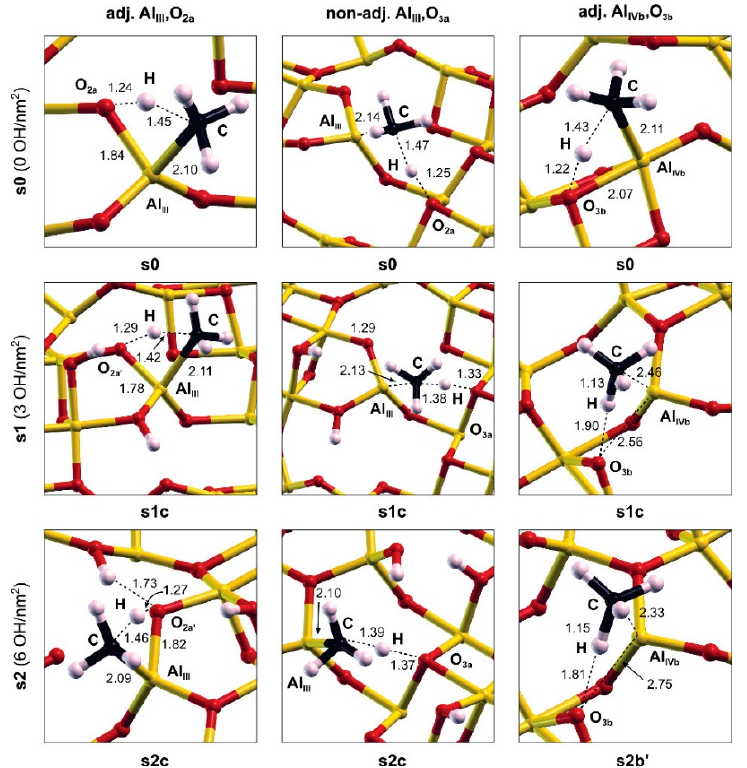
Figure 3. Configurations of the transition states for CH 4 dissociation on various surface Al–O pairs for surfaces at different OH coverages (0, 3 and 6 OH/nm 2 ). Adapted from reference [66] with permission.